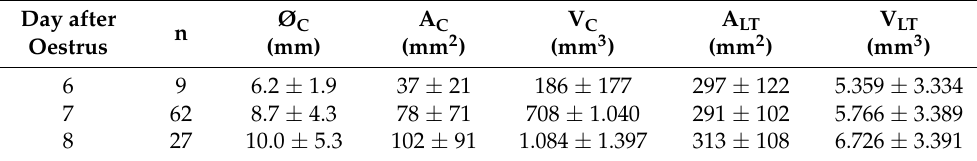
Table 5. Comparison of cavity and luteal tissue with the total dimension of CLs on days 6, 7, and 8 after oestrus.